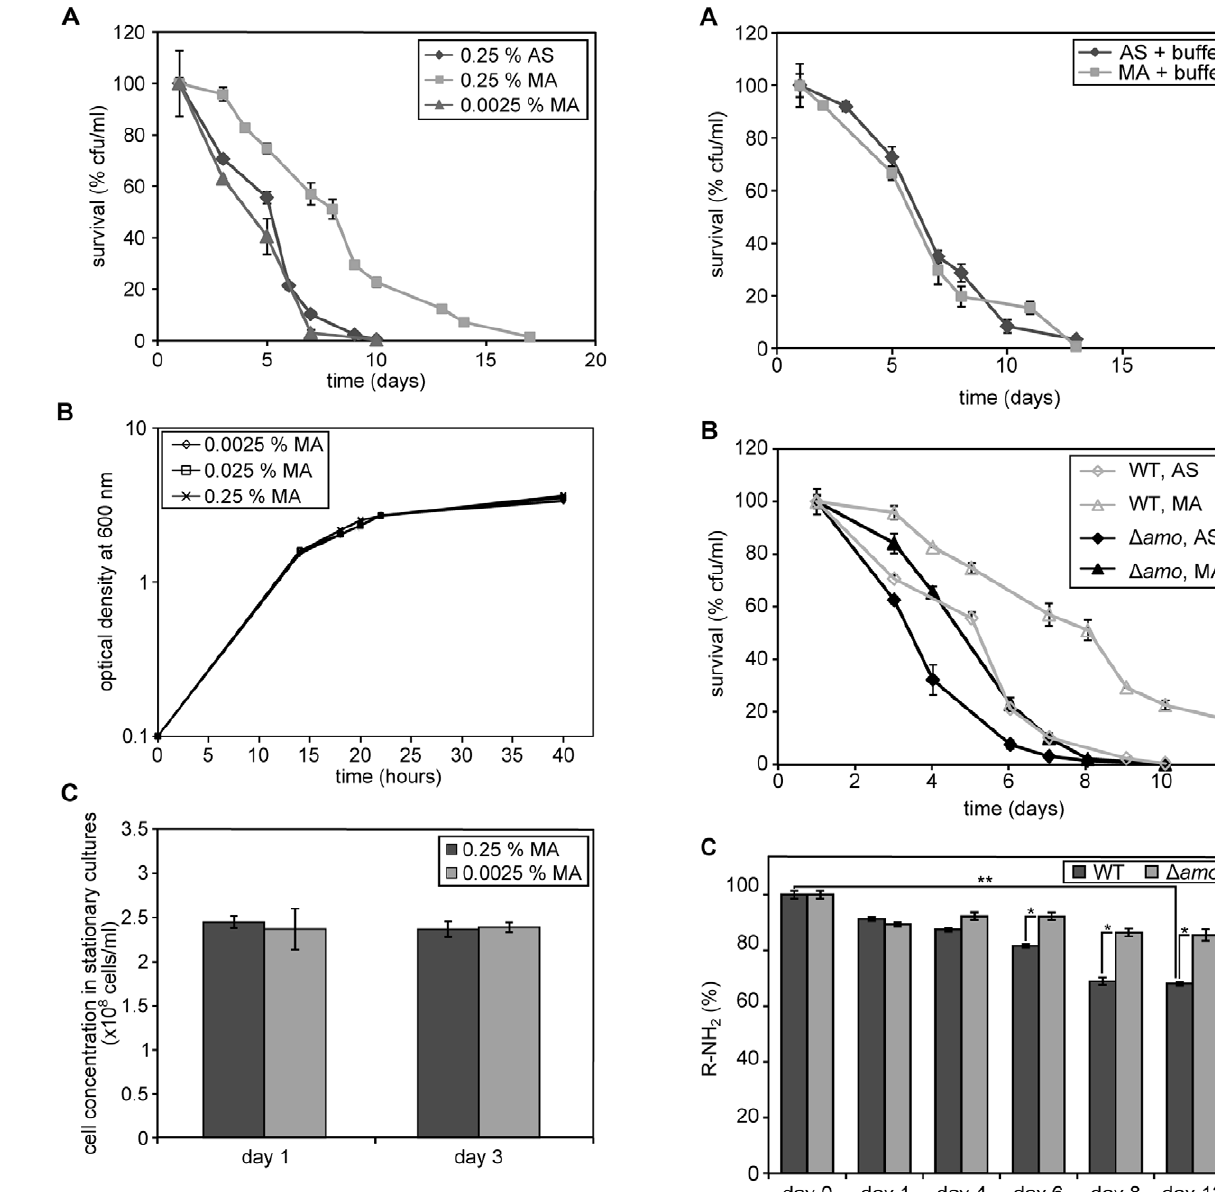
(Table 1). One explanation may be that prior to placing the glucose-grown cells in buffer, they already experienced the toxic effects related to the low pH when reaching the stationary phase.